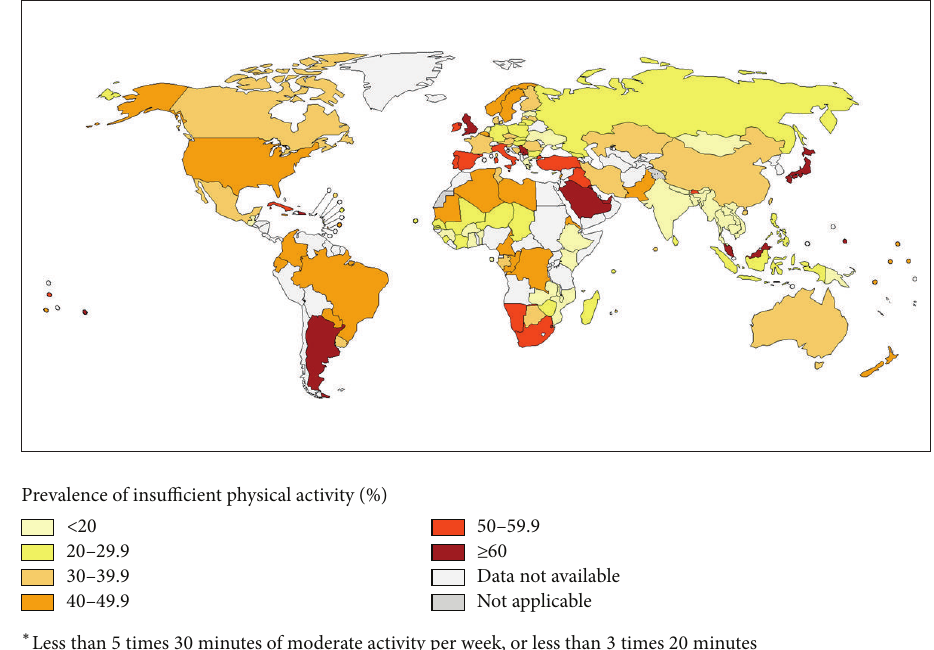
Figure 1: The Worldwide prevalence of adult physical inactivity. The prevalence of inactivity in the UK, highlighted in red, was 63% in 2008. Globally this value is approximately 31%. Taken from the Global Health Observatory of World Health Organization, 2008. The boundaries and names shown and the designations used on this map do not imply the expression of any opinion whatsoever on the part of the World Health Organization concerning the legal status of any country. Territory, city, or area or of its authorities, or concerning the delimitation of its frontiers or boundaries. Dotted lines on maps represent approximate border lines for which there may not yet be full agreement. Data source: World Health Organization. Map production: Public Health Information and Geographic Information System (GIS) World Health Organization. ©WHO 2011. All rights